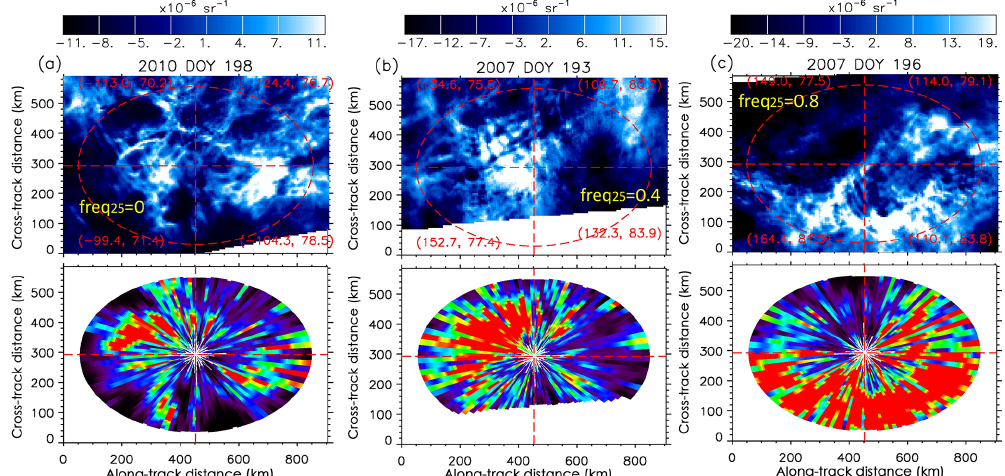
Figure 7. Albedo maps and the albedo power maps corresponding to the high-power category at three different brightness levels, each with the mean background albedo subtracted. The blue–white color scheme used linear RGB color code distribution. The albedo power maps used the same rainbow color bar as in Fig. 2. Based on the factors used to make the albedo power spectra collapse between the different brightness levels, which are ratio 0 . 4 / 0 . 8 = 1 . 44 and ratio 0 . 0 / 0 . 8 = 3 . 13, in this case (see Eqs. 1 and 2 in Sect. 5.1), the corresponding color bar maxima √ √ are reduced by factors 1.44 = 1.2 and 3.13 = 1.77, to achieve the same level of display